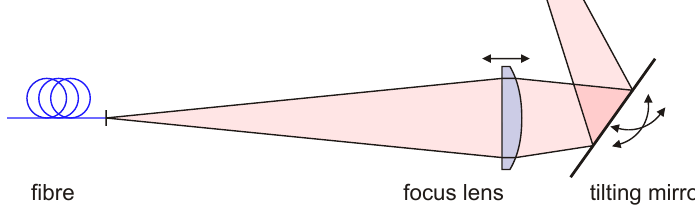
Figure 4. Principle of the optomechanical set-up: Each receiver consists of a servo-driven focus lens and a tilting mirror which is driven by a servo-piezo ensemble in order to provide sufficient resolution for accurate positioning at measurement heights up to 250 m. As the transmitter does not need to be tilted, it only consists of a focus lens and a fixed